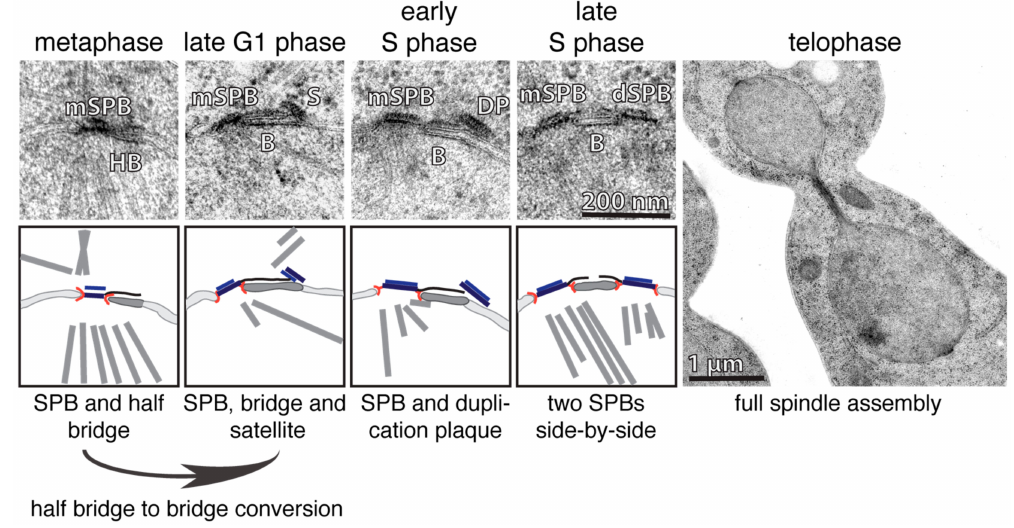
Figure 1. The duplication cycle of the ScSPB. The individual steps of the ScSPB duplication process are illustrated by EM micrographs ( top ) and corresponding cartoons ( bottom ). mSPB, mother SPB; HB, half bridge; B, bridge; S, satellite; DP, duplication plaque; dSPB, daughter